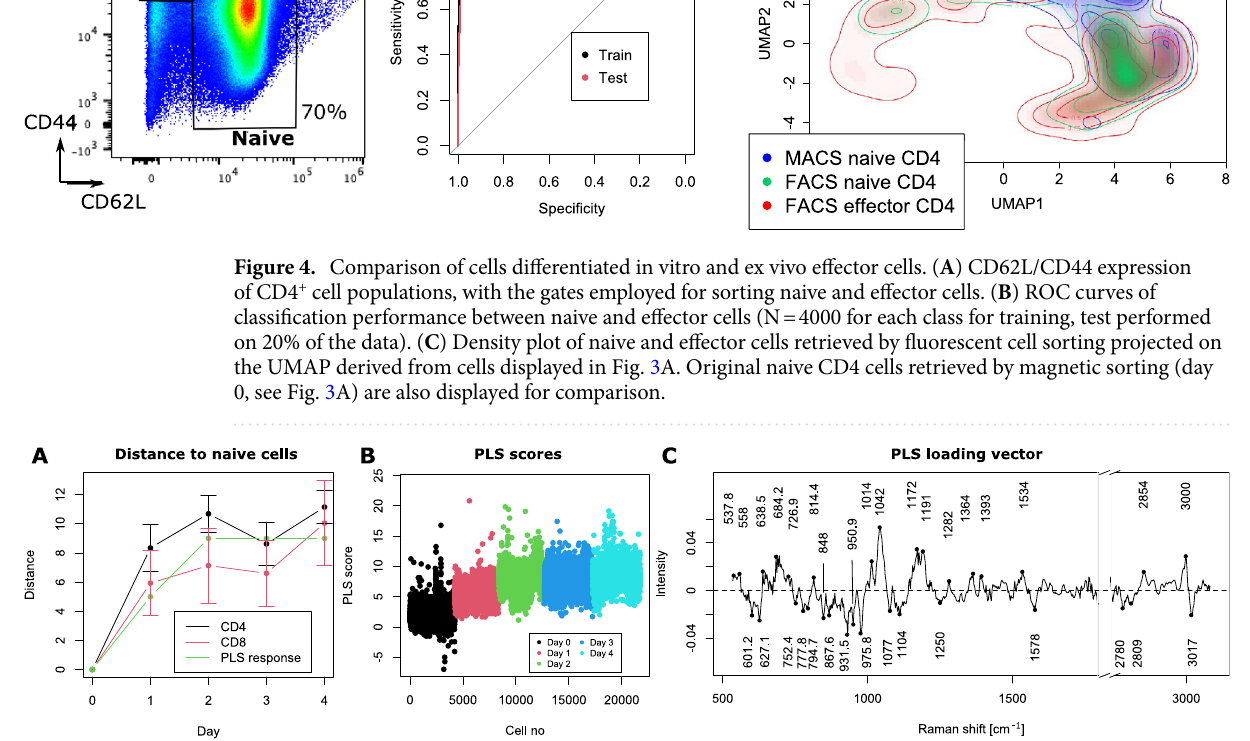
Figure 5. PLS model representing early differentiation. ( A ) Distance between cellular sub-populations, measured as a Mahalanobis-like distance and assigned matching response. ( B ) Single-cell scores derived from the PLS model, displaying the same increasing values as distances. ( C ) Resulting loading vector of the model, where peaks are representative of the activation and early